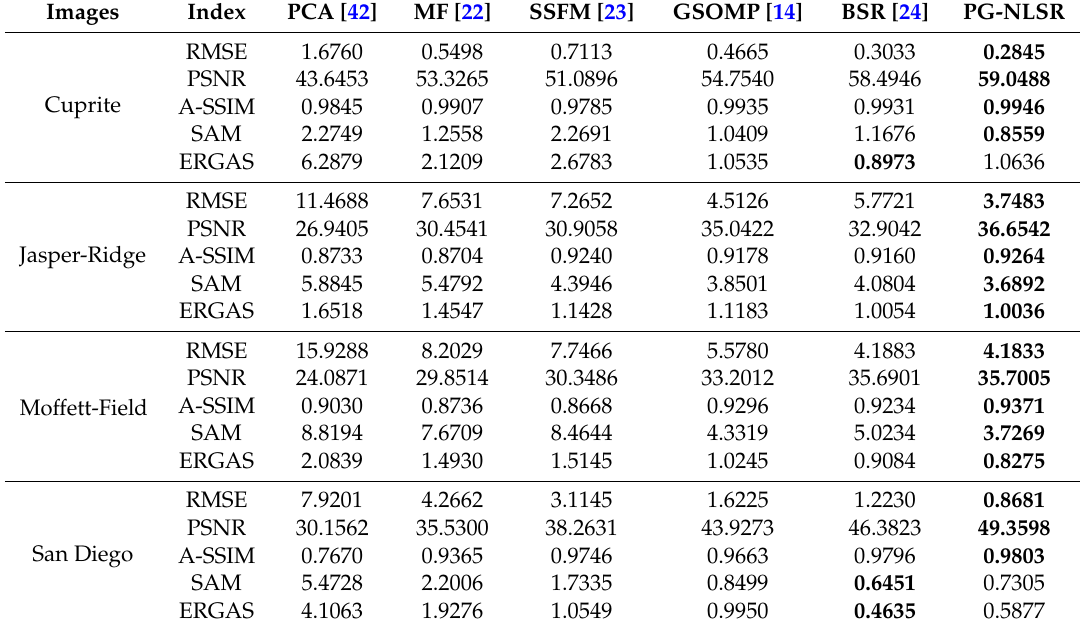
Table 1. Evaluation assessments of different fusion schemes for remote sensing HSIs.